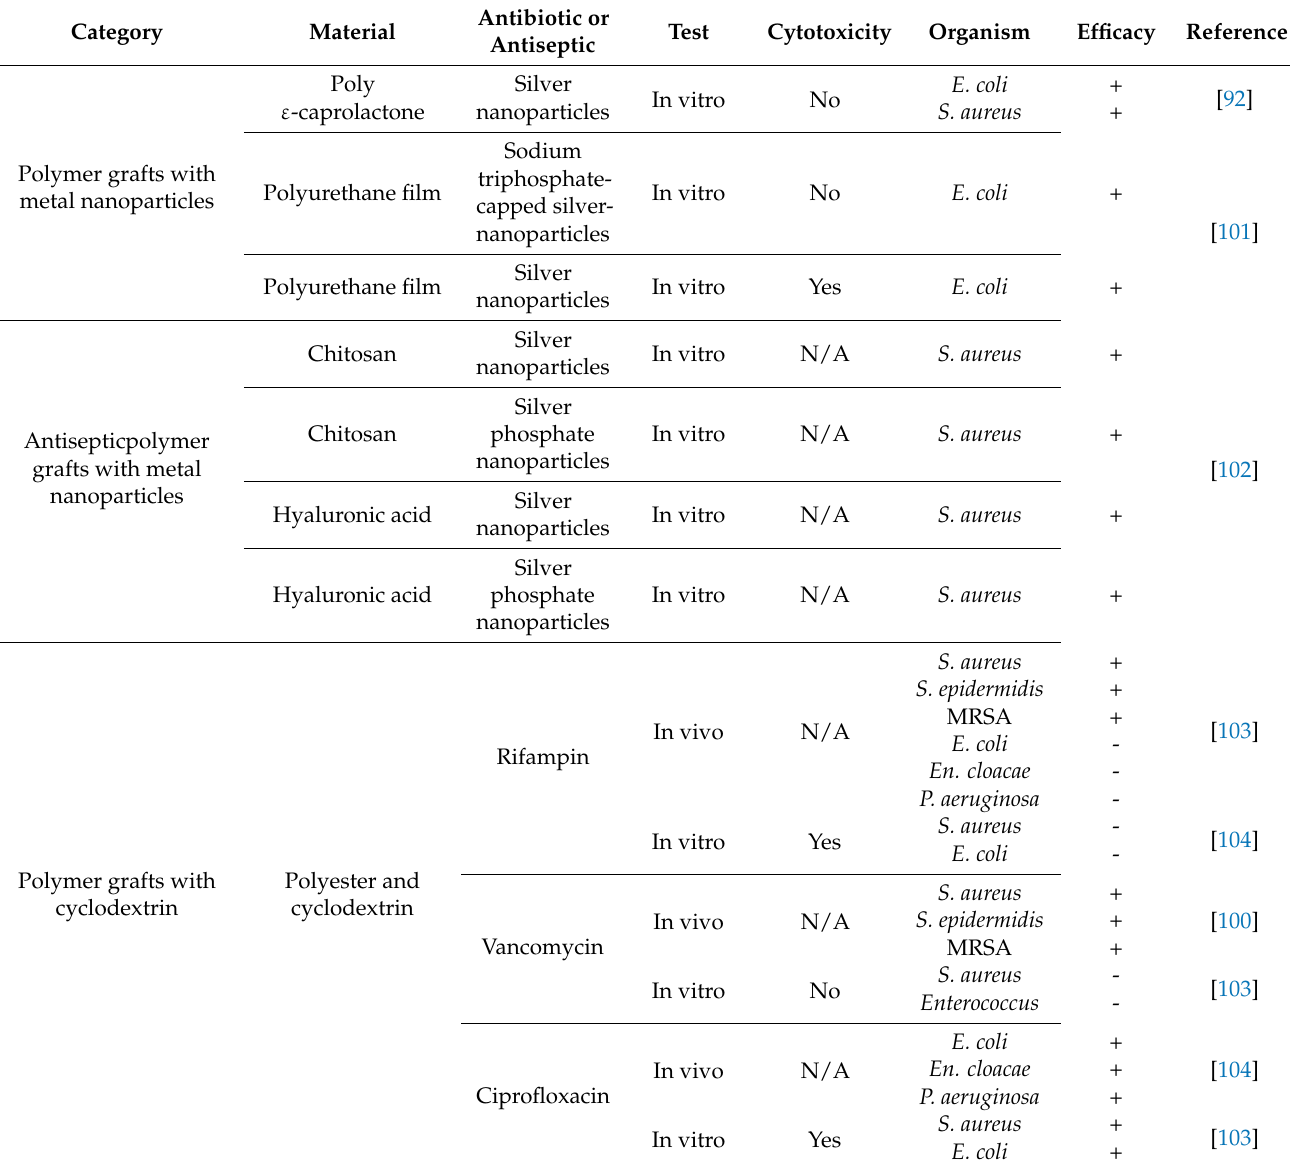
Table 2. Nanoparticle approaches to prevent VG